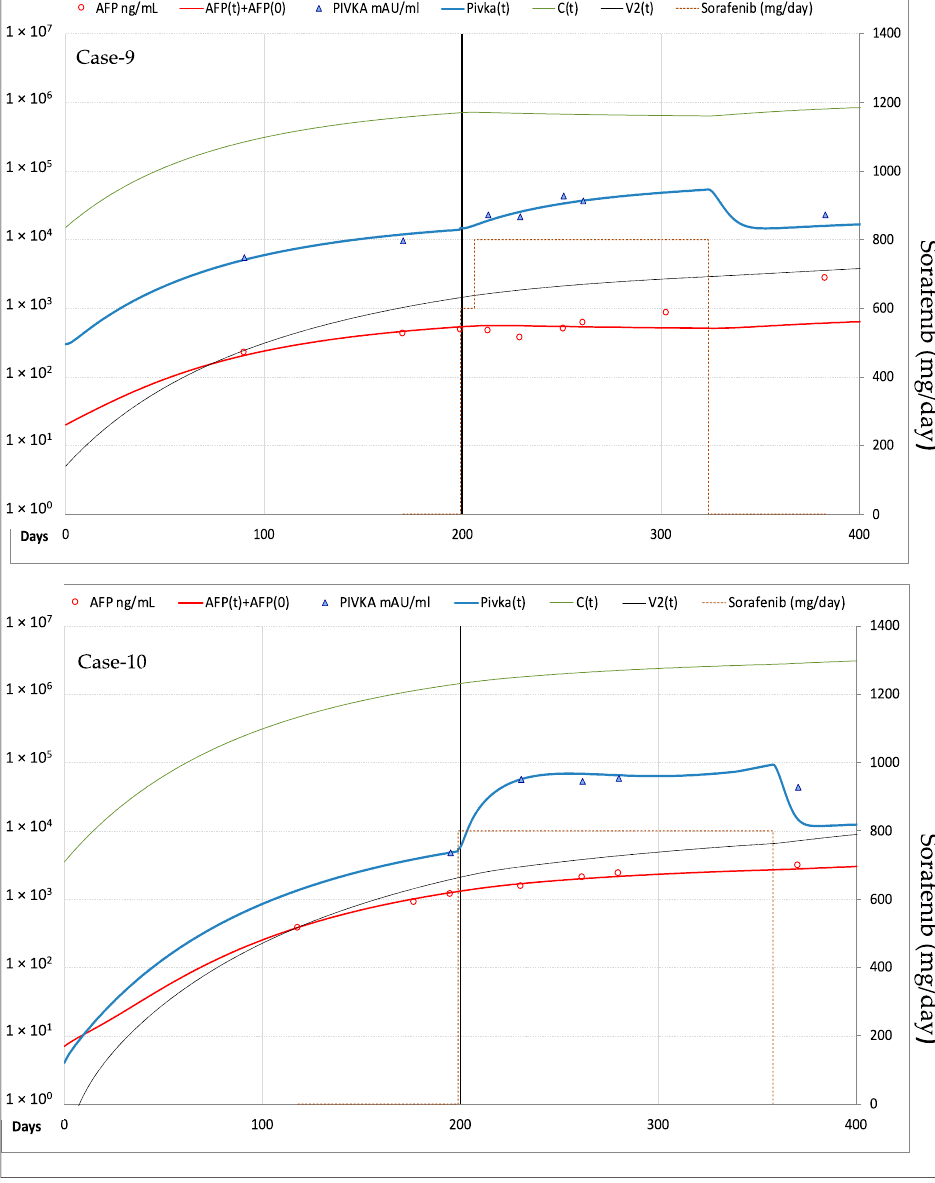
Figure 9. Best fitting of AFP and PIVKA-II serum levels in the 2 patients with PD of the target lesion. Case-9 showed a minimal initial response in term of AFP reduction. Legend : AFP = measured AFP; AFP(t) = model computed AFP; AFP(0) = AFP normal value; PIVKA-II = measured PIVKA-II; Pivka(t) = computed PIVKA-II; C(t) = model computed cancer cells; V2(t) = model computed vascularization index.